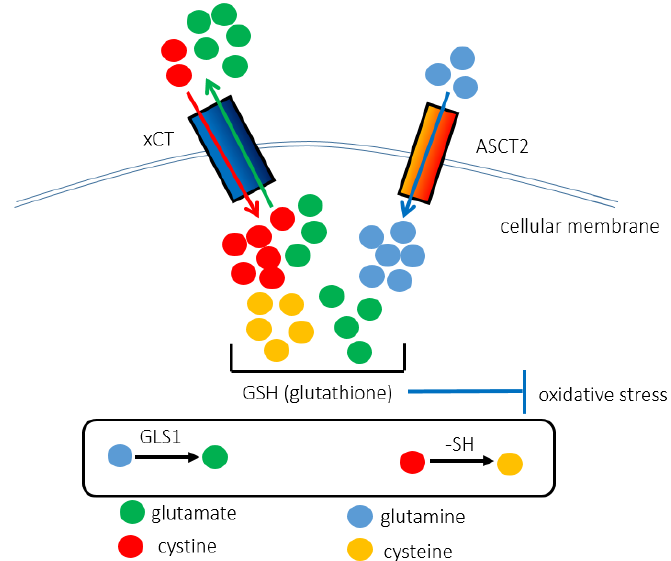
Figure 2. The interaction between ASCT2 and xCT contributes to the synthesis of GSH, rendering cancer cells resistant to redox stress. The xCT (SLC7A11) antiporter is responsible for importing cystine instead of exporting glutamate. ASCT2 (SLC1A5) promotes the uptake of glutamine. Glu- tamine and cystine are chemically converted into glutamate and cysteine, respectively. As GSH is composed of cysteine, glutamate, and glycine, the cooperative function of ASCT2 and xCT underlies the anti-oxidant stress machinery. That is why ASCT2-targeted therapy increases intracellular redox stress levels and induces ferroptosis, iron-dependent cell death.